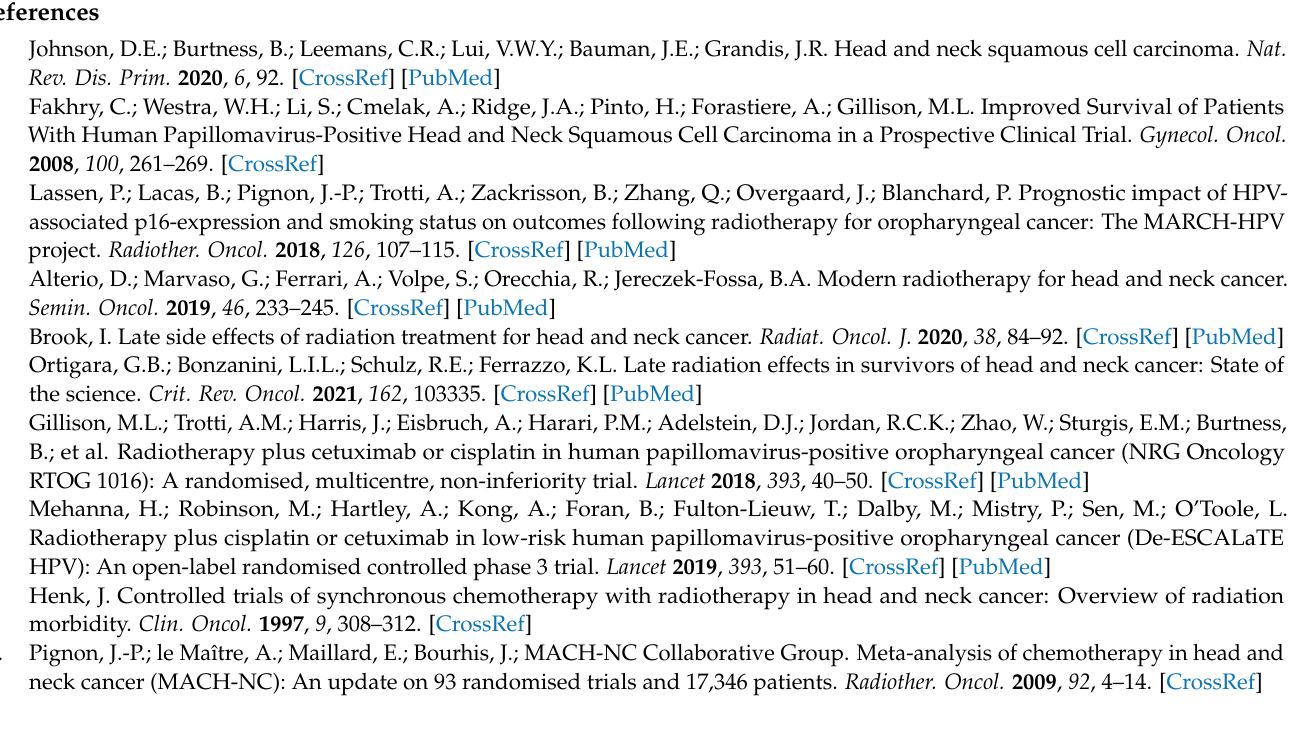
Figure S2: Irradiation with a single dose of 10 Gy induced marked apoptotic response and abolished proliferation in HNSCC tumor cells. Table S1: Composition of culture media used in the optimization of culture conditions of HNSCC tumor